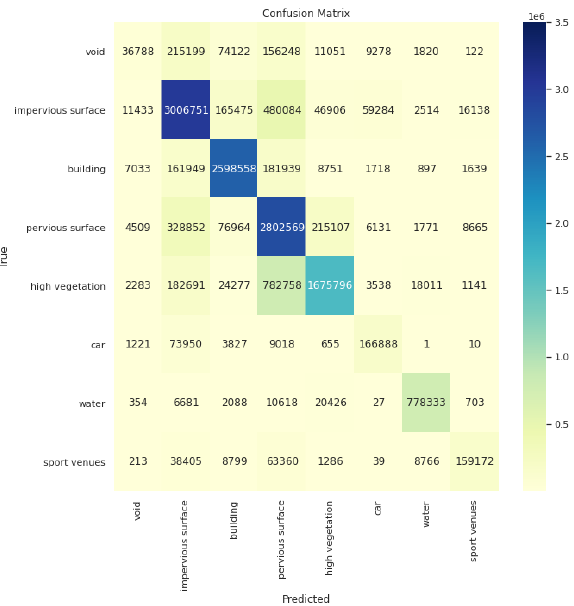
Figure 9. Confusion matrix of the NAS